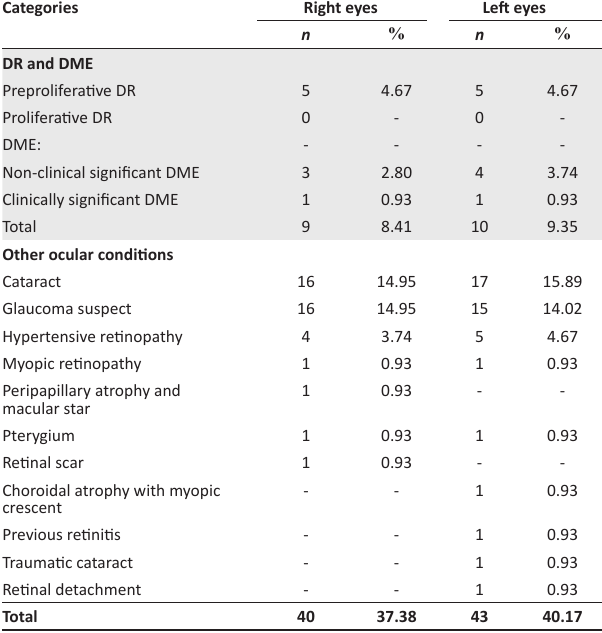
TABLE 6: Results of patients’ satisfaction survey completed by 107 participants. Categories